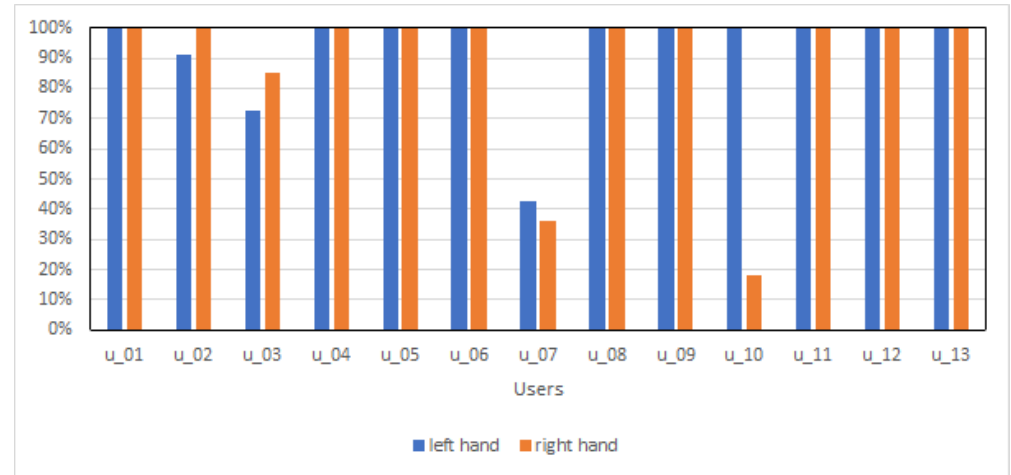
Figure 12. Accuracy of gesture recognition by